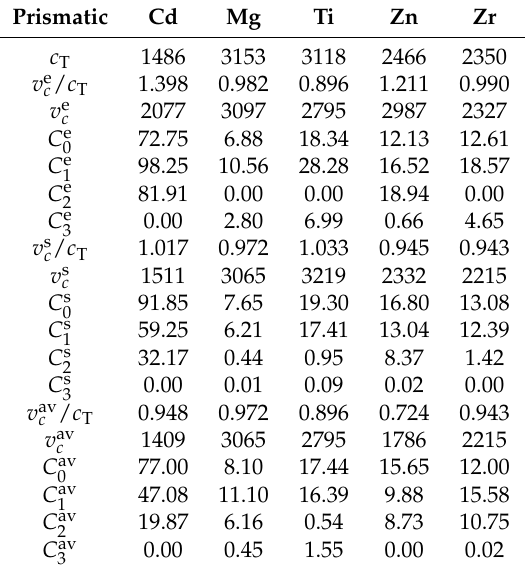
Table 5. List of critical velocities v c (m/s), and fitting function coefficients C i ( µ Pas) for prismatic slip. The critical velocities are given in units of m/s as well as in ratio to c T . The fits are only valid up to 0.99 c T and do not capture the asymptotic behavior for those metals/dislocations whose critical velocity is larger than this value. Superscripts “e”, “s”, and “av” refer to “edge”, “screw”, and “average”, respectively. Furthermore, v av c coincides with the smallest critical velocity for all dislocation characters ϑ within the prismatic slip system. Prismatic Cd Mg Ti Zn Zr